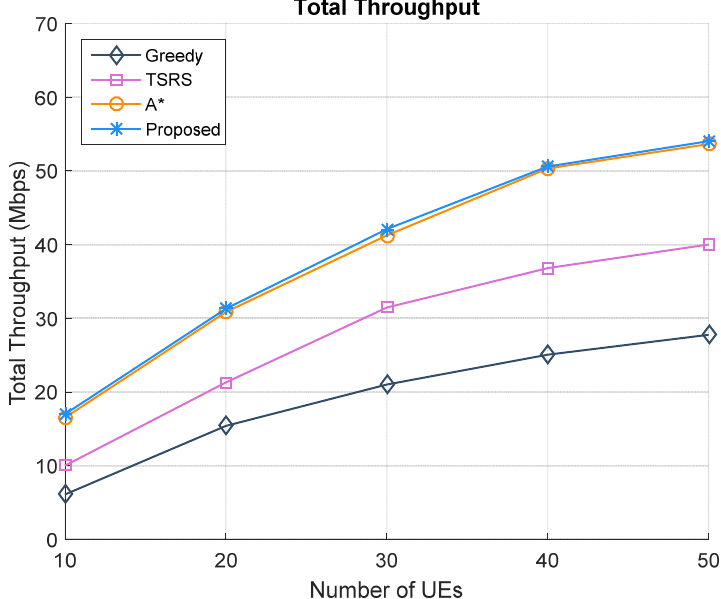
Figure 11. Throughput vs. number of UEs.